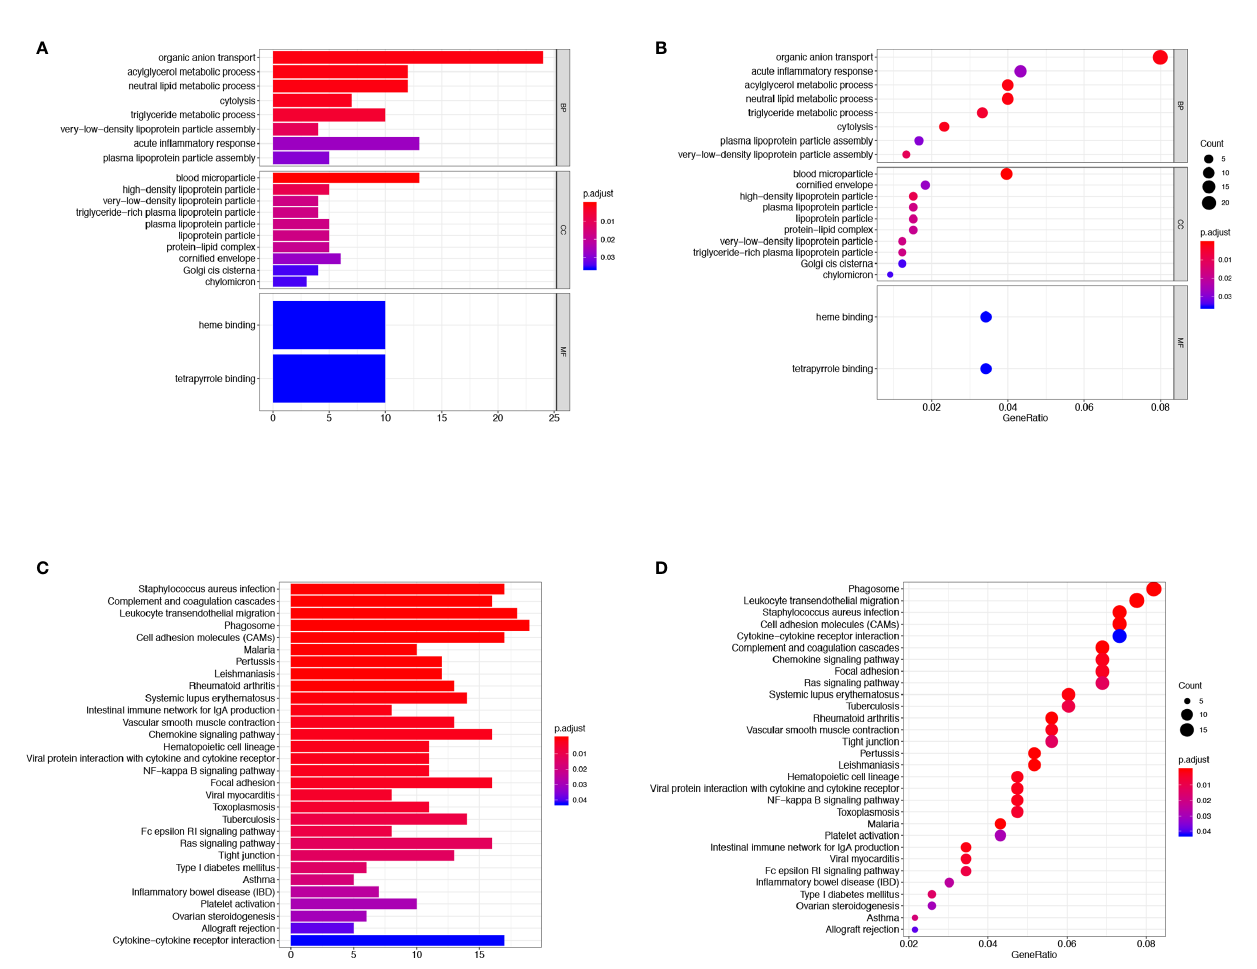
FIGURE 4 | GO term and KEGG pathway analysis for DEGs signi fi cantly associated with TME in fi ltration in ICC. The GO functional clustering and KEGG pathway enrichment analysis were carried out utilizing the DAVID. The results of the GO (A, B) and the KEGG pathway enrichment analyses (C, D) for the identi fi cation of DEGs in